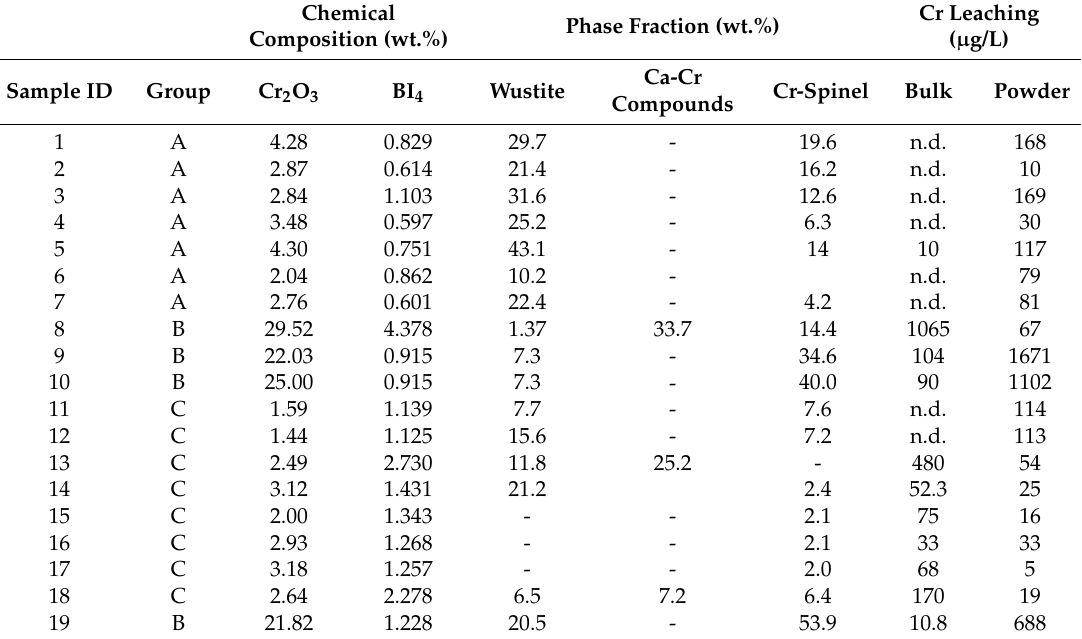
Table 1. Chemical and mineralogical characterization and leaching test results for the investigated